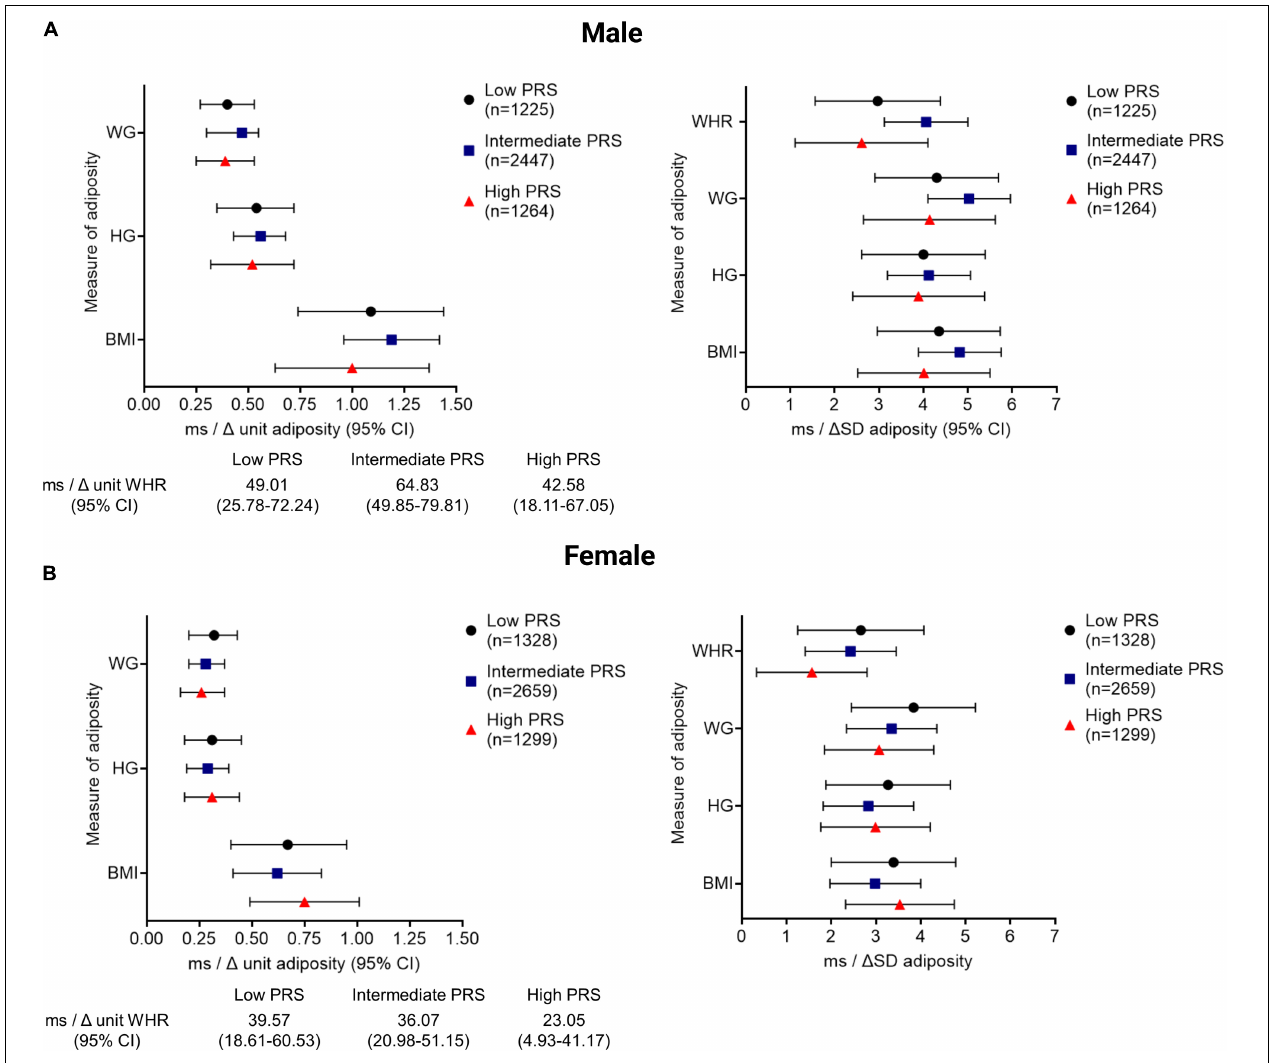
FIGURE 3 | The QTc interval prolongs comparably with increasing adiposity in men and women stratified by PRS. The change in the QTc per unit and per SD increment of adiposity [quantified by BMI, body mass index (kg/m 2 ); HG, hip girth (cm); WG, waist girth (cm); WHR, waist; hip ratio (unit)] is shown stratified according to low ( < 25%), intermediate (25–75%), and high ( > 75%) PRS, representing high, intermediate, and low repolarisation reserve, respectively for men (A) and women (B) . All associations between QTc and adiposity measures reached statistical significance with p <